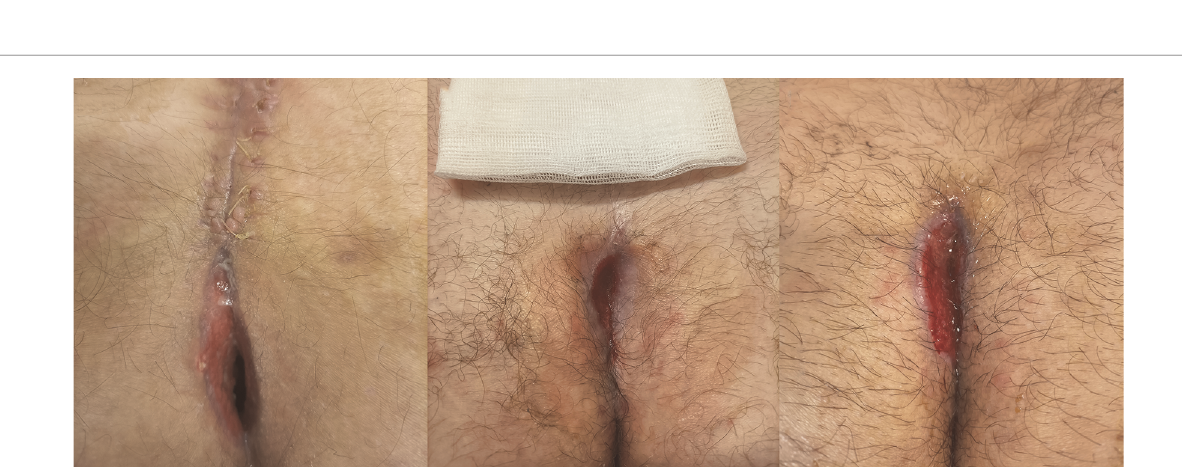
FIGURE 2 Surgical wounds ’ clinical appearance after 3 weeks of NovoX treatment.